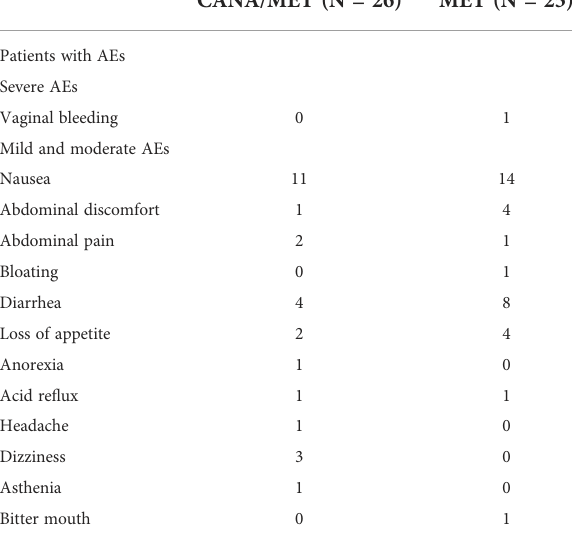
TABLE 3 AEs of two treatment